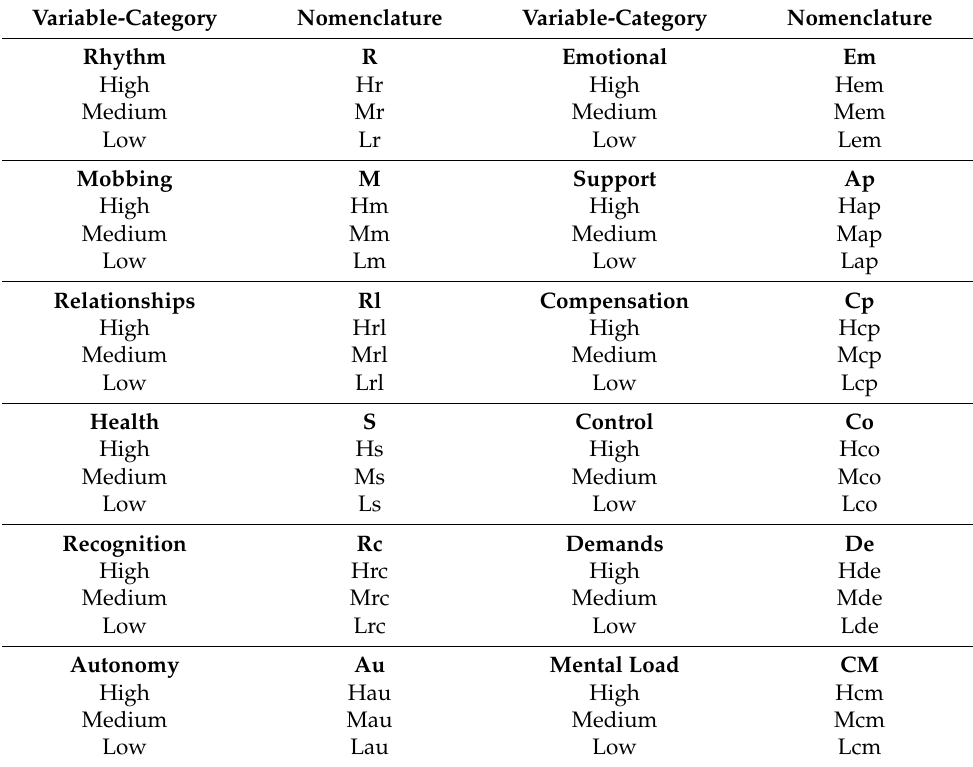
Table A5. Nomenclature of the risk level categories for each of the 12 assessed psychosocial factors used in the multiple correspondence